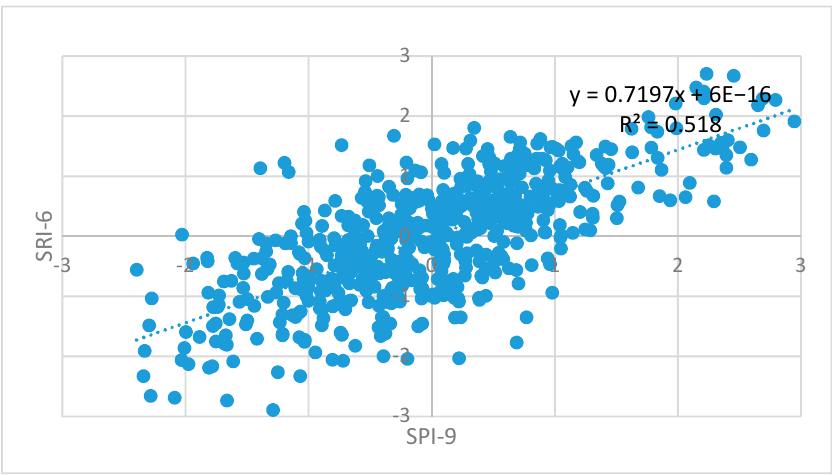
Figure 6. Correlation between SPI-9 at the Medzilaborce station and SRI-6 at the Humenne station in the period 1970–2019.